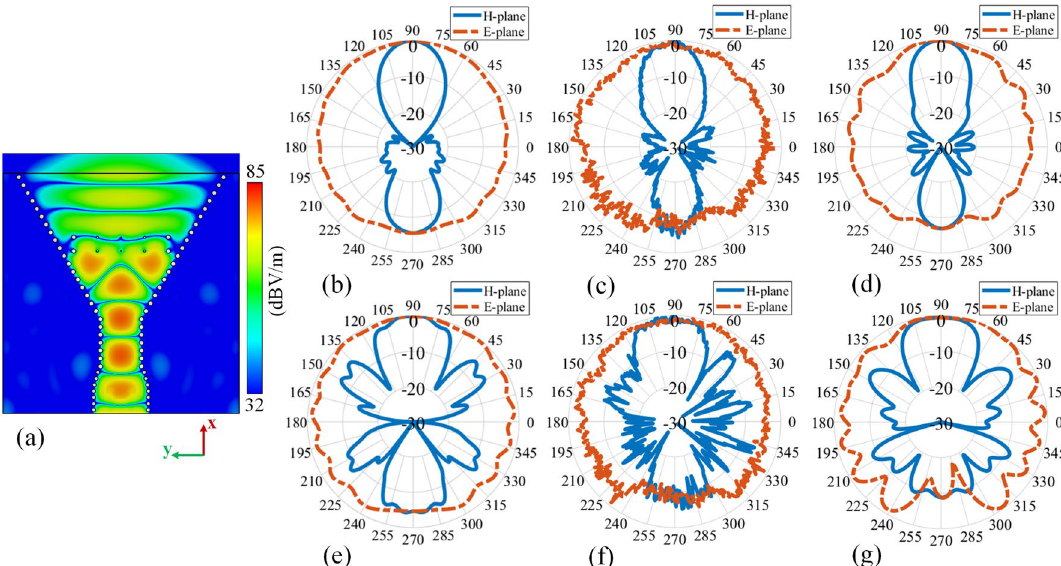
Figure 7. Performance at 30 GHz: ( a ) the simulated |E-field| distribution pattern of the proposed loaded SIW H-plane horn antenna. The normalized radiation pattern: ( b ) simulated loaded structure without the connector, ( c ) measured loaded structure, ( d ) simulated loaded structure with the connector, ( e ) simulated conventional structure without the connector, ( f ) measured conventional structure, ( g ) simulated conventional structure with the connector.